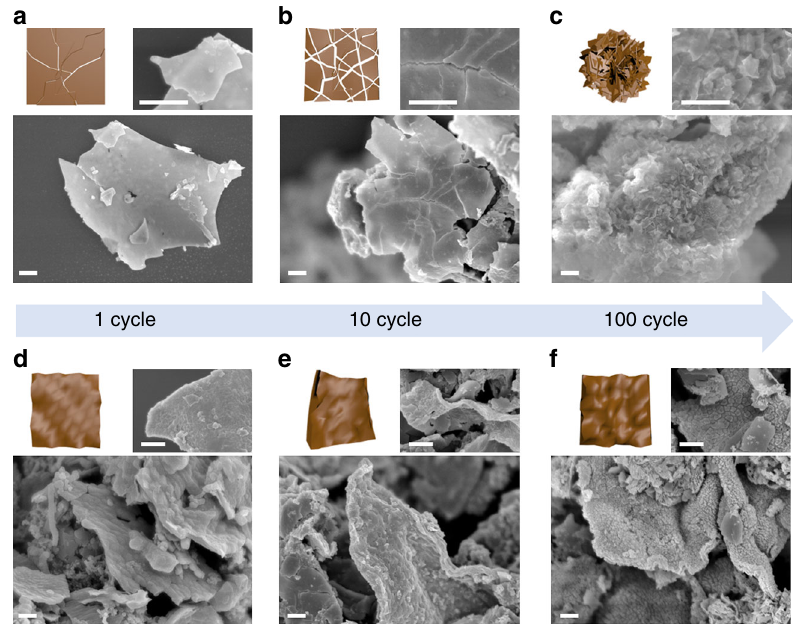
Fig. 5 The morphology changes in a single sheet. A series of SEM images of a – c 2DSi and d – f 2DSi@C after 1, 10, and 100 cycles, respectively (Inset: schematic illustration of each morphology and high magni fi cation SEM images). Scale bars are 1 μ